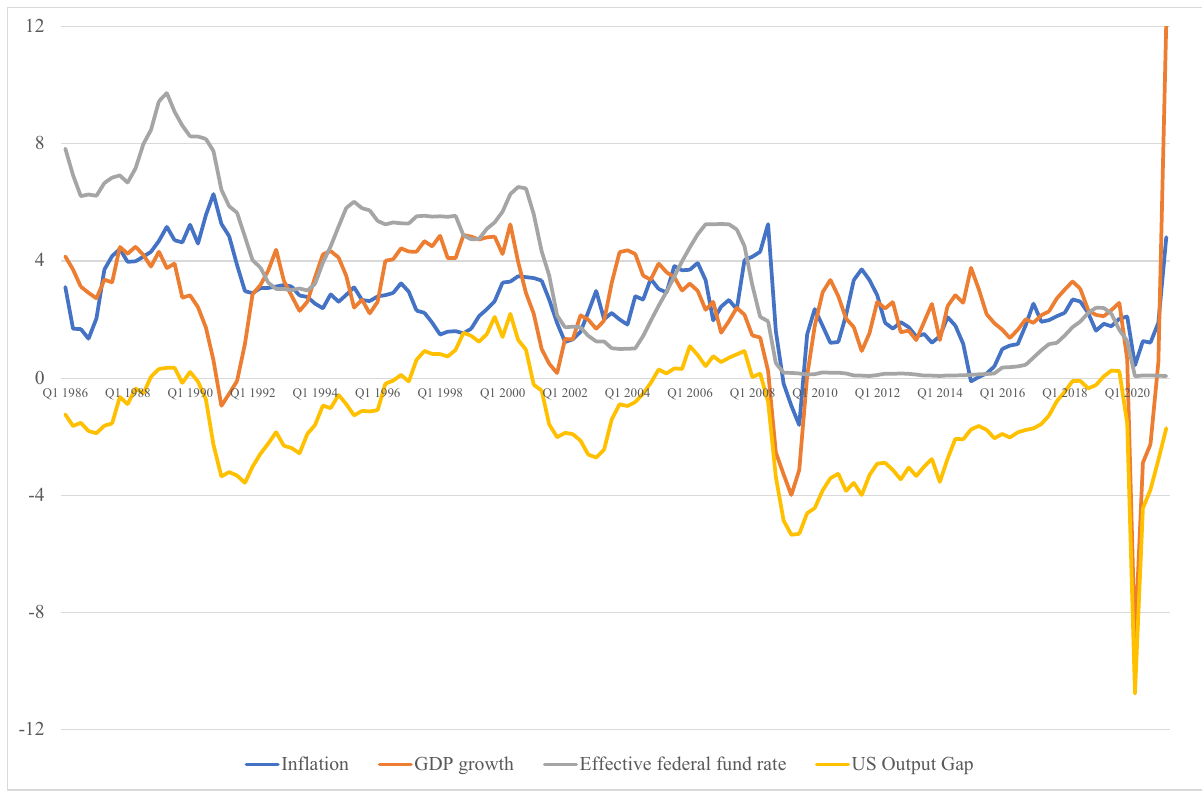
Figure 1: Time series for in fl ation, output - gap and interest rate for the US